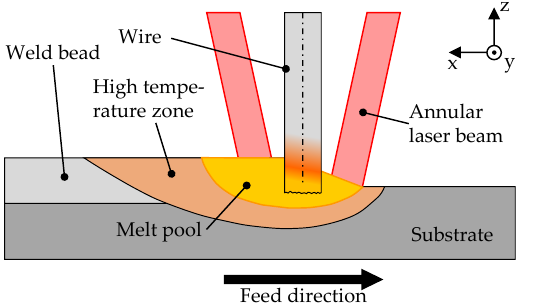
Figure 1. Schematic illustration of the process zone in laser metal deposition with coaxial wire feeding.